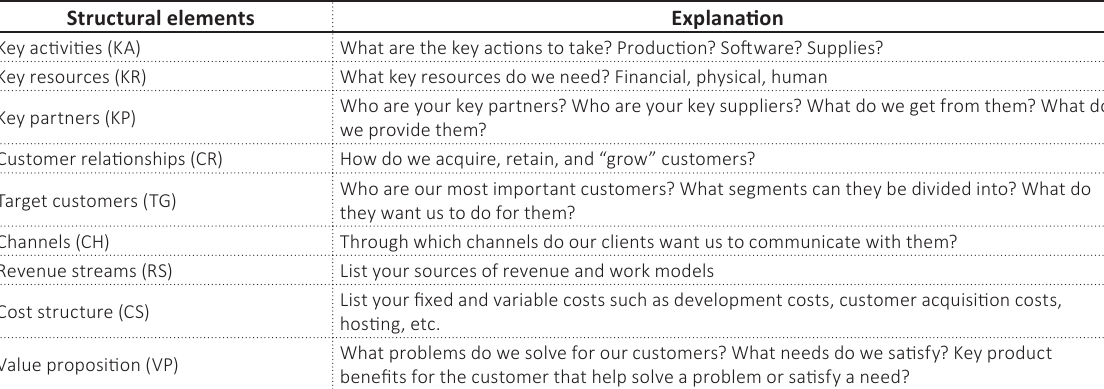
Table 1. Key structural elements of Business Model Canvas Structural elements